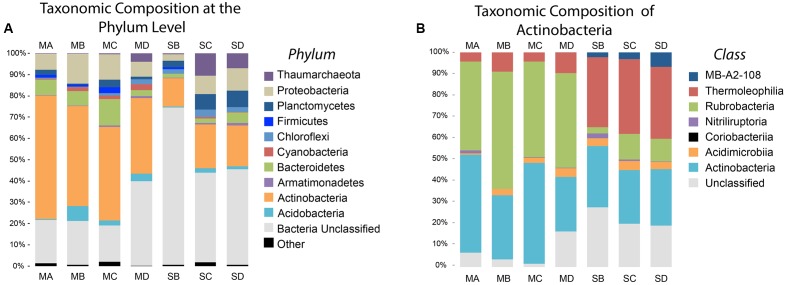
Phyla and Actinobacteria Abundance of Meteorites and Soil. This figure shows the relative abundance of different phyla and classes. (A) The major phyla classified according to the Silva taxonomy identification. ‘Other’ phyla include all phyla present at abundances less than 3%. ‘Bacteria Unclassified’ were OTUs that could not be classified below the domain Bacteria. (B) Taxonomic composition of the important soil phylum, Actinobacteria.